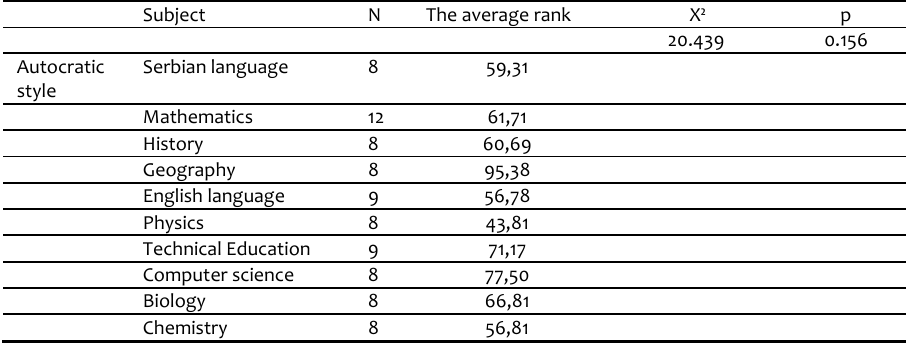
Table 2. Differences in teachers' assessments of autocratic work